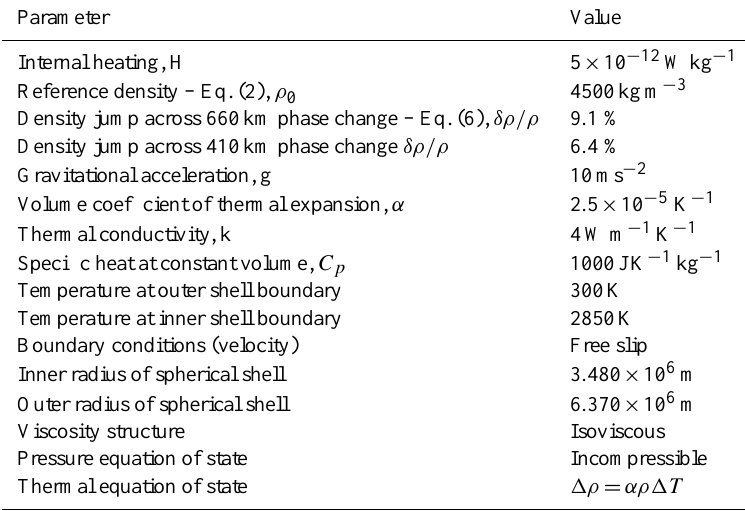
Table 1. Common input